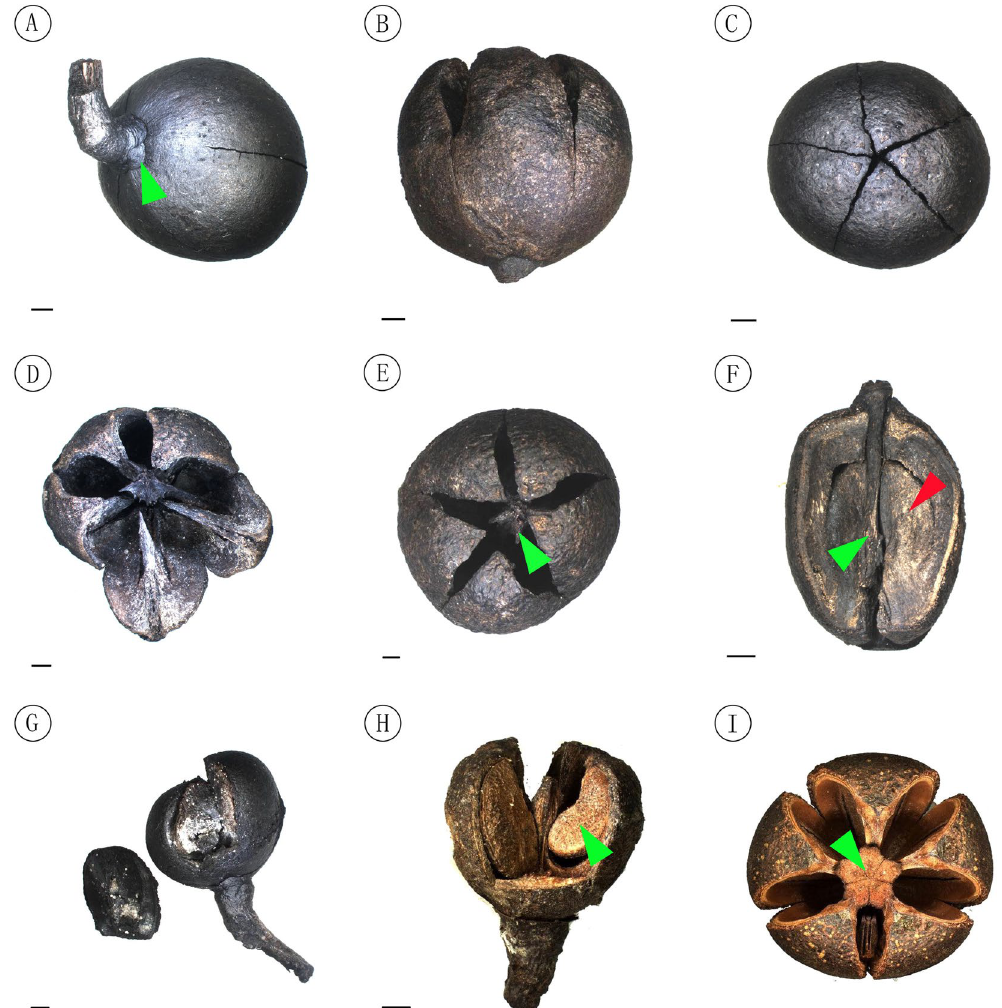
Figure 4. Fruit structure of Schima kwangsiensis sp. nov. and extant Schima superba . ( A–G ) Fossil fruits: ( A ) Dehiscent capsule showing semiorbicular sepals (green arrowhead), specimen number NNF-072. ( B ) Dehiscent capsule showing splits running down the upper 2/3 of the capsule length, specimen number NNF-1493. ( C ) Dehiscent capsule with five ventral sutures, specimen number NNF-1495. (D) Dehiscent capsule showing 5 valves and dissepiments, specimen number NNF-1490. (E) Dehiscent capsule showing five locules and the persistent five-angled columella (green arrowhead), specimen number NNF-1491. (F) Half capsule showing the persistent columella (green arrowhead) and reniform seed (red arrowhead), specimen number NNF-1499. ( G ) Dehiscent capsule with a deciduous valve, specimen number NNF-076. (H,I) Modern fruits of the species Schima supberba : ( H ) Partially dehiscent capsule showing reniform seeds. (I) Pentacarpellate, loculicidally dehiscent capsule showing apically 5-angled columella (green arrowhead). Scale bar = 2 mm. Processed and drawn by X. G. Shi using Adobe Photoshop